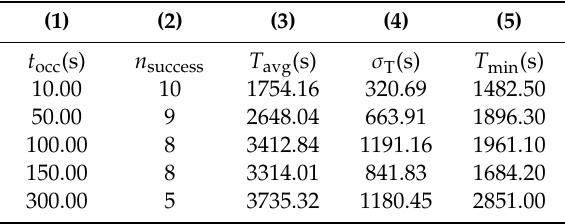
Table 1. Simulation results for various t occ for three vehicles.